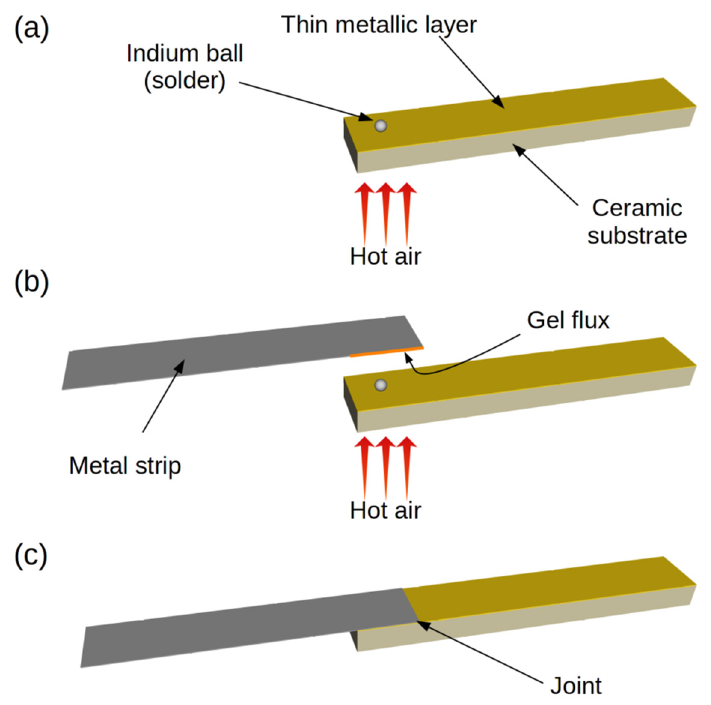
Figure 1. New three-stage process for soldering a metal strip to a thin metallic layer sputtered on a ceramic substrate: ( a )—Solder melting; ( b )—Placing a metal strip with a flux over the melted solder; ( c )—Cooling the joint.